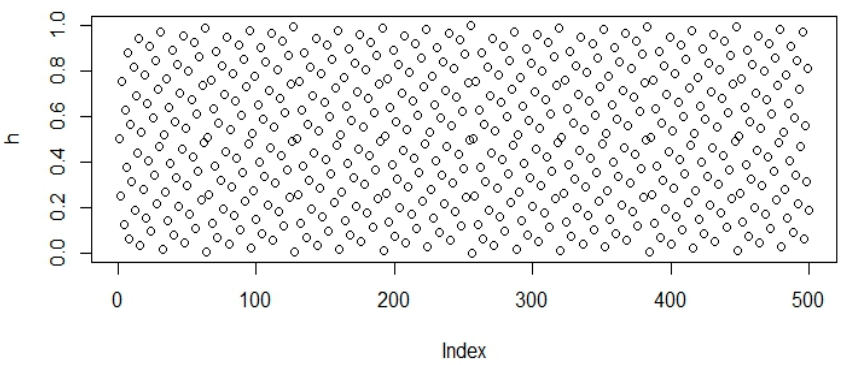
Figure 2. Population initialization using Sobol distribution .